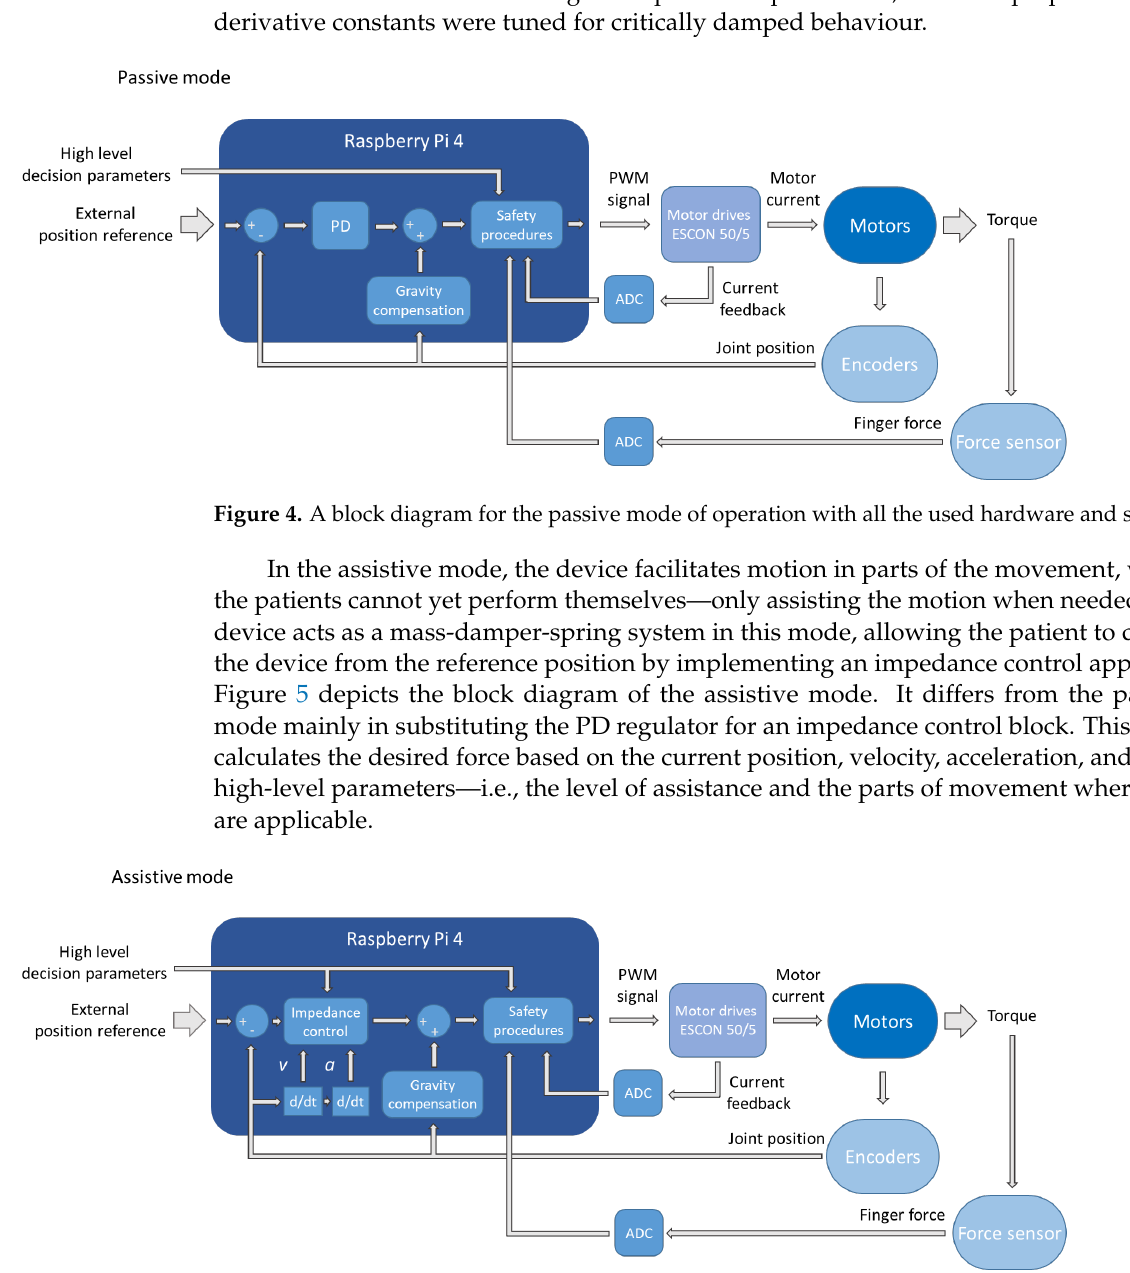
Figure 5. A block diagram for the assistive mode of operation with all the used hardware and